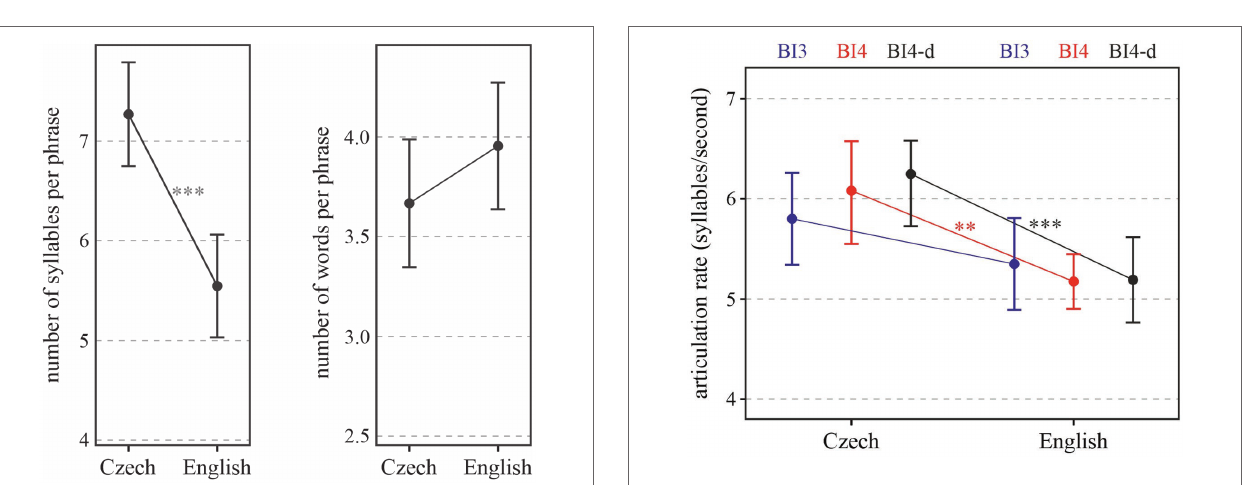
FIGURE 4 | Articulation rate depending on L anguage and P rosodic break type (BI3 in blue, BI4 in red, and BI4-d in black). ** p < 0.05; *** p < 0.001.